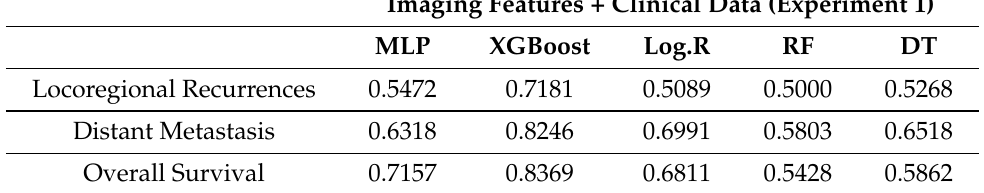
Table 2. Global results (AUC values) of LR, DM, and OS predictions for the imaging features + clinical data (Experiment 1) models.